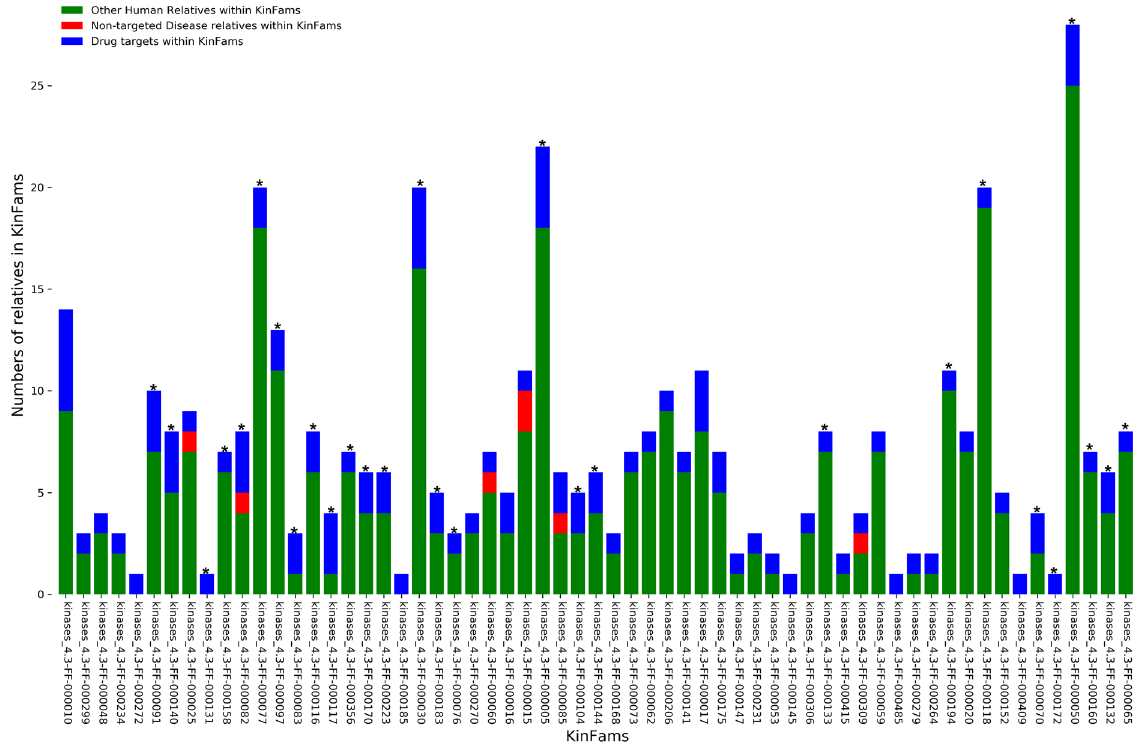
Figure 12. KinFams association with drug targets, i.e., 28 druggable KinFams based on overrepresentation of drug targets in the KinFam (shown as asterisk).